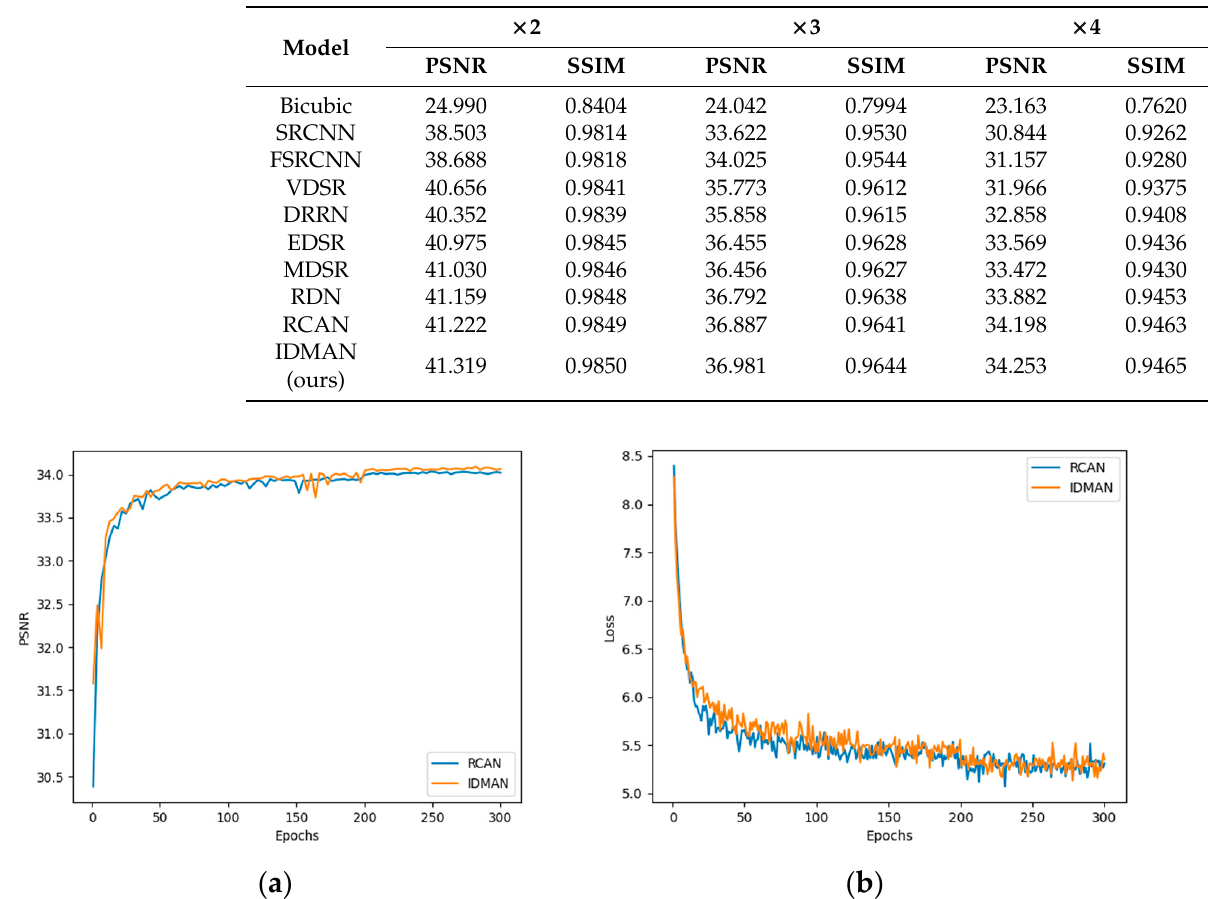
Table 8. The average PSNR and SSIM results of different algorithms in Lung-PET-CT-Dx dataset with different scaling factors.